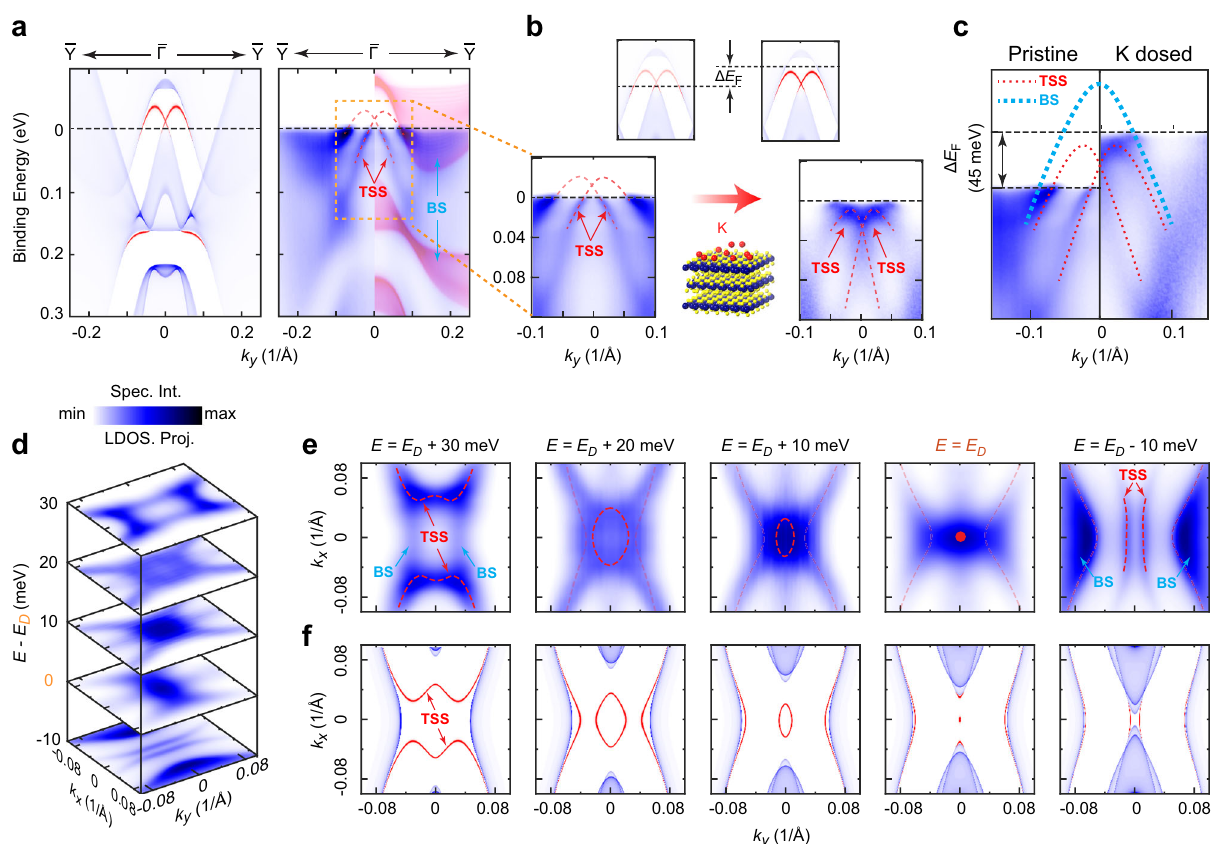
Fig. 3 Band structure of the topological surface states. a Comparison between slab calculation (left) and photoemission (right) band dispersions along (cid:1) Y (cid:1) (cid:1) Γ (cid:1) (cid:1) Y direction. The TSSs are highlighted by red color (left) and indicated by the red dashed lines (right). The bulk dispersions around Γ point (red shaded area, k z integration window is 0.06 π /a ) are overlapped to better illustrate the TSSs (right). b Bottom left: Zoomed in dispersion of the TSS in the pristine sample covering the yellow box area in the right panel of a . The red dashed lines show the TSS dispersions. Top left: Schematic of the calculated dispersions for comparison and the E F is marked as a black dashed line. Bottom right: Full dispersion of the TSS band observed after in situ potassium (K) doping (illustrated as the middle inset). Top right: Calculated dispersions with the new E F position indicated after the K-dosing, showing a clear upshift Δ E F . c Side-by-side comparison of TSS dispersions before (left panel) and after (right panel) K-dosing, shows a Δ E F of ~45 meV. d Stacking plots of the experimental constant energy contours (CECs) at different energy close to the Dirac point, showing rapid evolution. e , f Comparison between experimental ( e ) and ab initio calculated ( f ) CECs evolution near the Dirac point showing overall agreement. For clarity, the CECs of the TSSs are highlighted by red color. In e , the faded red dashed lines represent the less visible TSSs due to the hybridization to the bulk